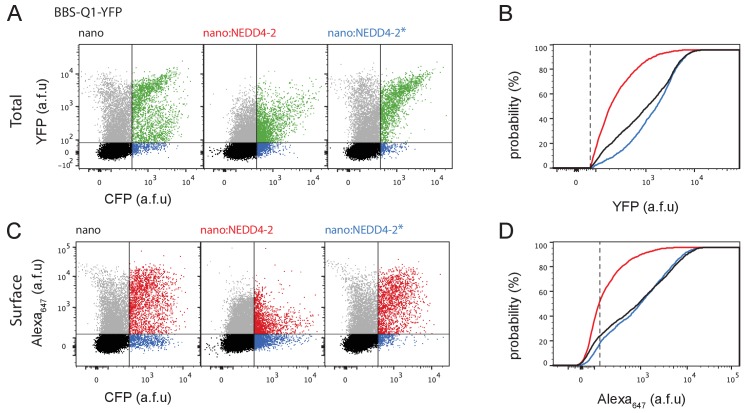
Engineered nanoNEDD4-2 decreases both Q1 surface density and total protein expression.(A) Flow cytometry analyses of total Q1 expression (YFP fluorescence) in cells expressing BBS-Q1-YFP + nanobody (left, control), BBS-Q1-YFP + nanoNEDD4-2 (center), and BBS-Q1-YFP + nanoNEDD4-2* [C942S] (right). (B) Cumulative distribution histograms of YFP fluorescence for BBS-Q1-YFP co-expressed with either nanobody alone (black line), nanoNEDD4-2 (red line), and nanoNEDD4-2* [C942S] (blue line). (C) Flow cytometry analyses of surface Q1 channels (Alexa647 fluorescence) in cells expressing BBS-Q1-YFP + nanobody (left, control), BBS-Q1-YFP + nanoNEDD4-2 (center), and BBS-Q1-YFP + nanoNEDD4-2* [C942S] (right). (D) Cumulative distribution histograms of Alexa647 fluorescence for BBS-Q1-YFP co-expressed with either nanobody alone (black line), nanoNEDD4-2 (red line), and nanoNEDD4-2* [C942S] (blue line).